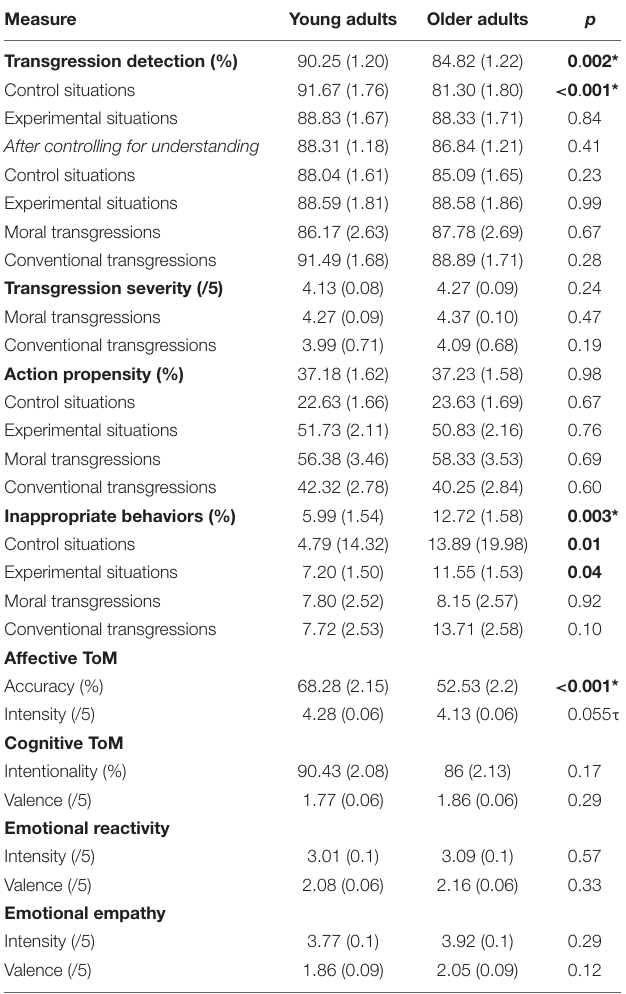
TABLE 3 | Performance on sociocognitive measures from the REALSoCog task in young and older adults. Measure